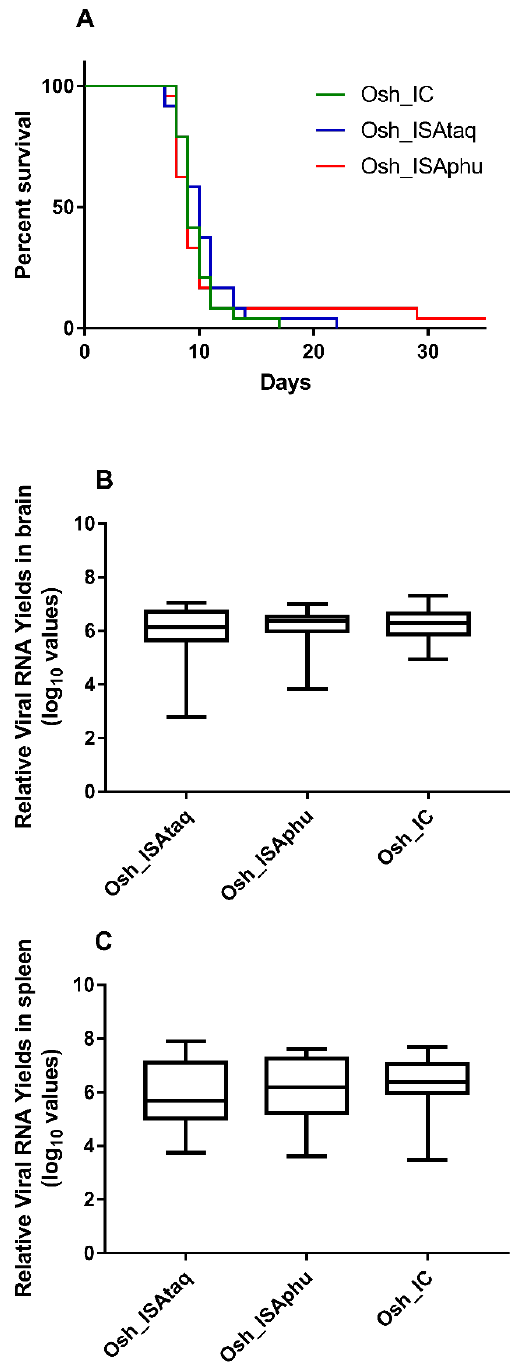
Figure 4. Survival curves ( A ) and viral RNA yields in collected organs ( B – C ). Group of twenty four mice were intra-peritoneally inoculated with 2 × 10 6 TCID 50 of each virus. Survival curves were established based on human endpoints ( A ). Brains ( B ) and spleens ( C ) of these animals were used to determine viral RNA yields using a quantitative real-time RT-PCR assay. The bottoms and tops of the boxes represent the first and third quartiles, the dashes inside the boxes represent the median values, and the ends of the error bars represent the minimum and maximum values.